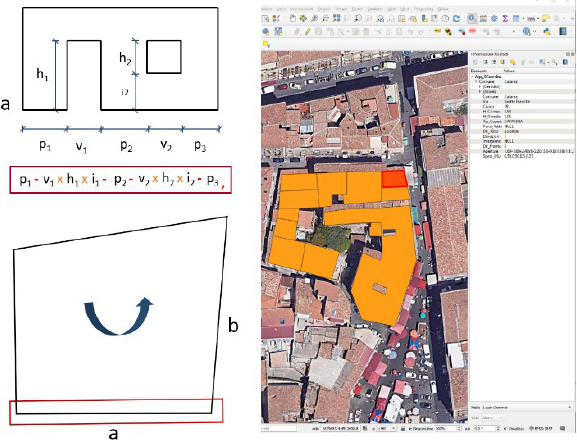
Figure 4 . From left, convention for openings and shape file.